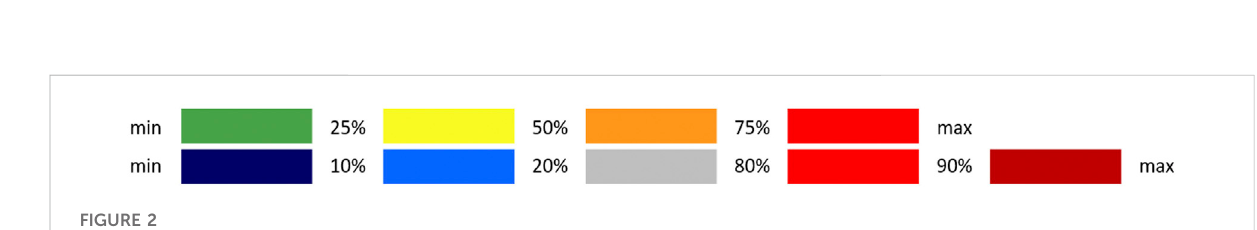
FIGURE 2 Colour coding of measured (top) and calculated (bottom) parameter.